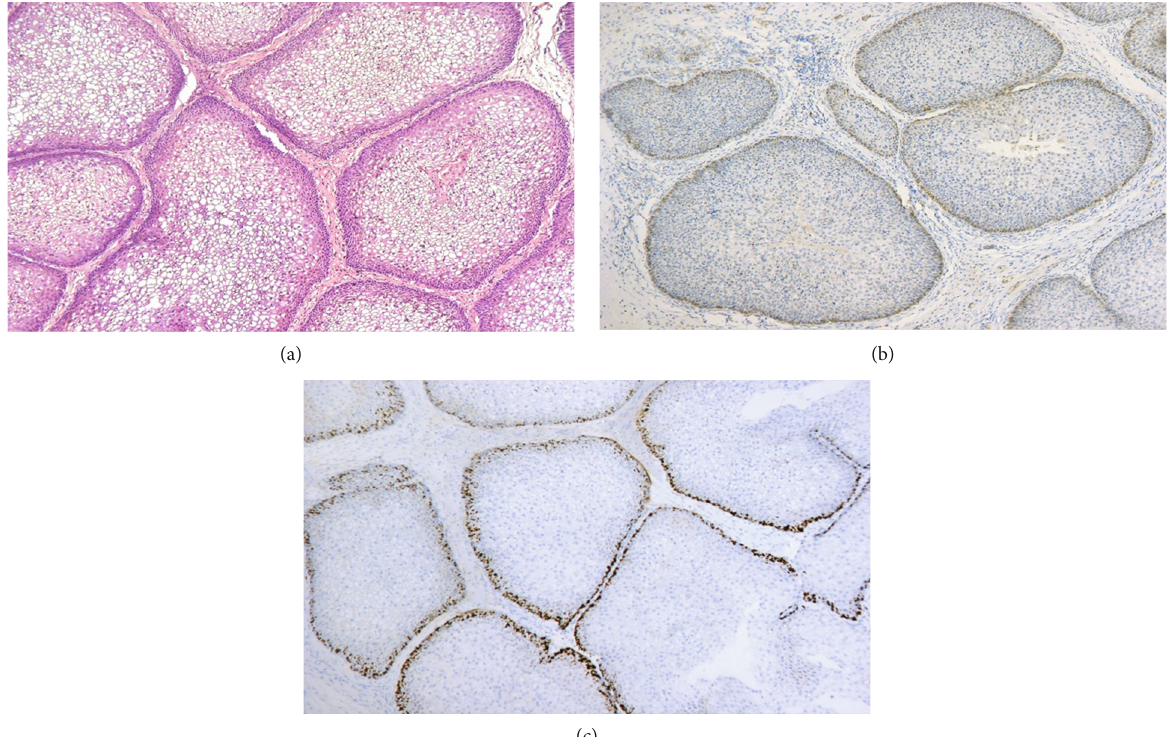
Figure 2: Sinonasal inverted papilloma: (a) by H&E (H&E × 100); (b) by IMP3 showing low intensity of cytoplasmic staining in outermost epithelial cell layer of the IP masses (IHC × 100); (c) by Ki-67 showing scattered nuclear expression of moderate intensity in outermost layer of IP masses (IHC ×